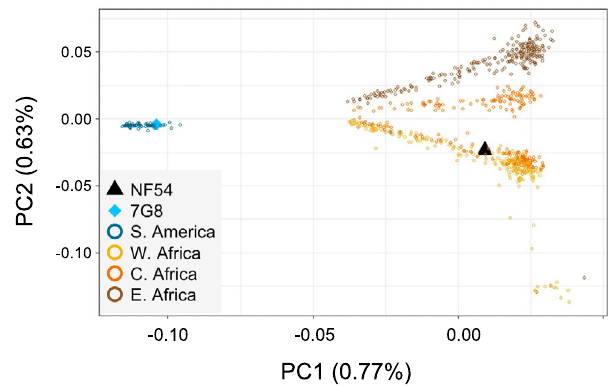
Fig. 2 Principal component analysis (PCA) of African and South American clinical malaria samples, as well as PfNF54 and Pf7G8. The analysis includes samples from West Africa (Mali, Guinea, and Burkina Faso; n = 234), Central Africa (Cameroon and the Democratic Republic of the Congo; n = 229), and East Africa (Kenya, Tanzania, Malawi, and Madagascar; n = 241), as well as from two South American countries (Brazil, n = 23; French Guiana, n-34) near the collection site of Pf7G8, in the Brazilian Amazon. The fi rst PC (PC1) differentiates S. American (blue) from African strains. PC2 separates samples from the three regions in the African continent, where there is a clear differentiation between E. African (brown), Central African (orange), and W Africa (yellow). Some samples collected in Central African countries present the genomic signature of West Africa, as shown by the clustering of some orange samples with yellow samples, suggesting parasite migration through the vector or the human host. PfNF54 (black triangle) is clearly nested among W African samples, while Pf7G8 (blue diamond) clusters with those from S. America.